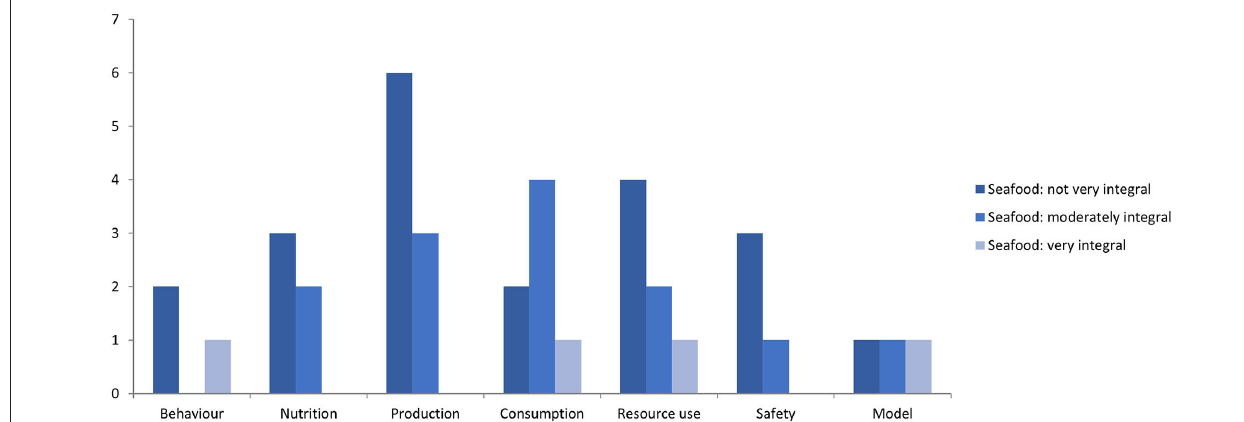
FIGURE 4 | Importance of seafood to the papers, by theme.